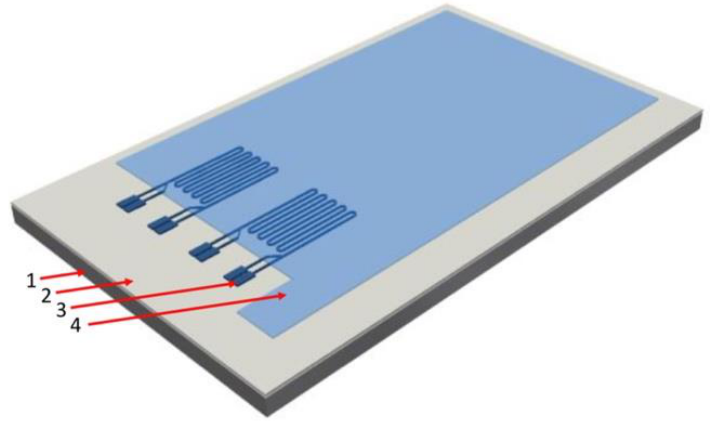
Figure 18. The schematics of screen-printed strain gauges in between coating layers. (1) Sheet steel. (2) Organic primer pre-applied factory side. (3) Screen-printed silver/carbon black strain gauge. (4) Top coating layer for mechanical protection and stabilization. Reprinted with permission from ref. [104]. Elsevier,